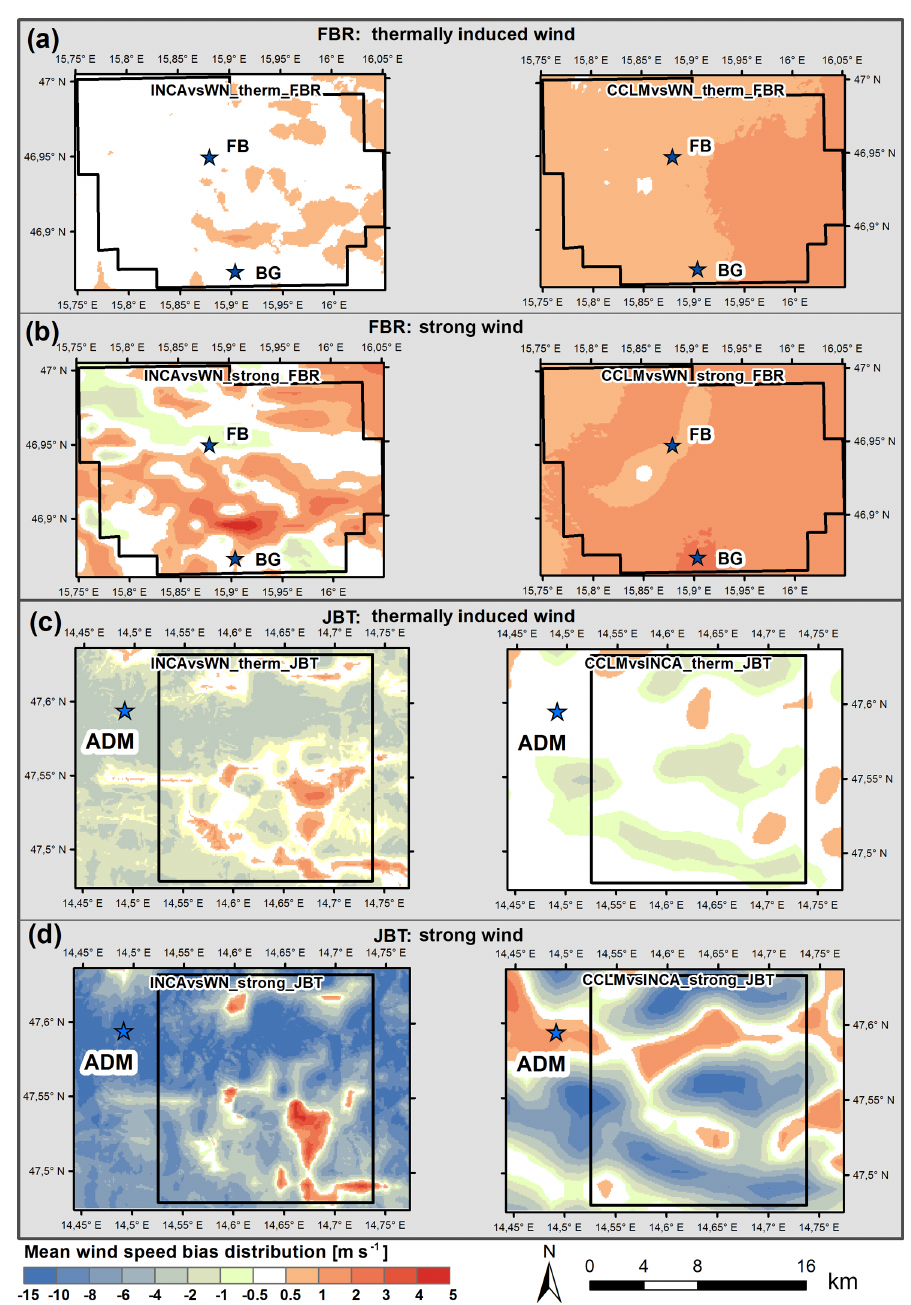
Figure 4. Mean wind speed bias distribution for the WegenertNet FBR (a, b) and the WegenerNet JBT (c, d) : (a, b) INCA versus WegnerNet (left) and CCLM versus WegenerNet (right) for (a) thermally induced wind events and (b) strong wind events and (c, d) WegenerNet versus INCA (left) and CCLM versus INCA (right) for (c) thermally induced wind events and (d) strong wind events.